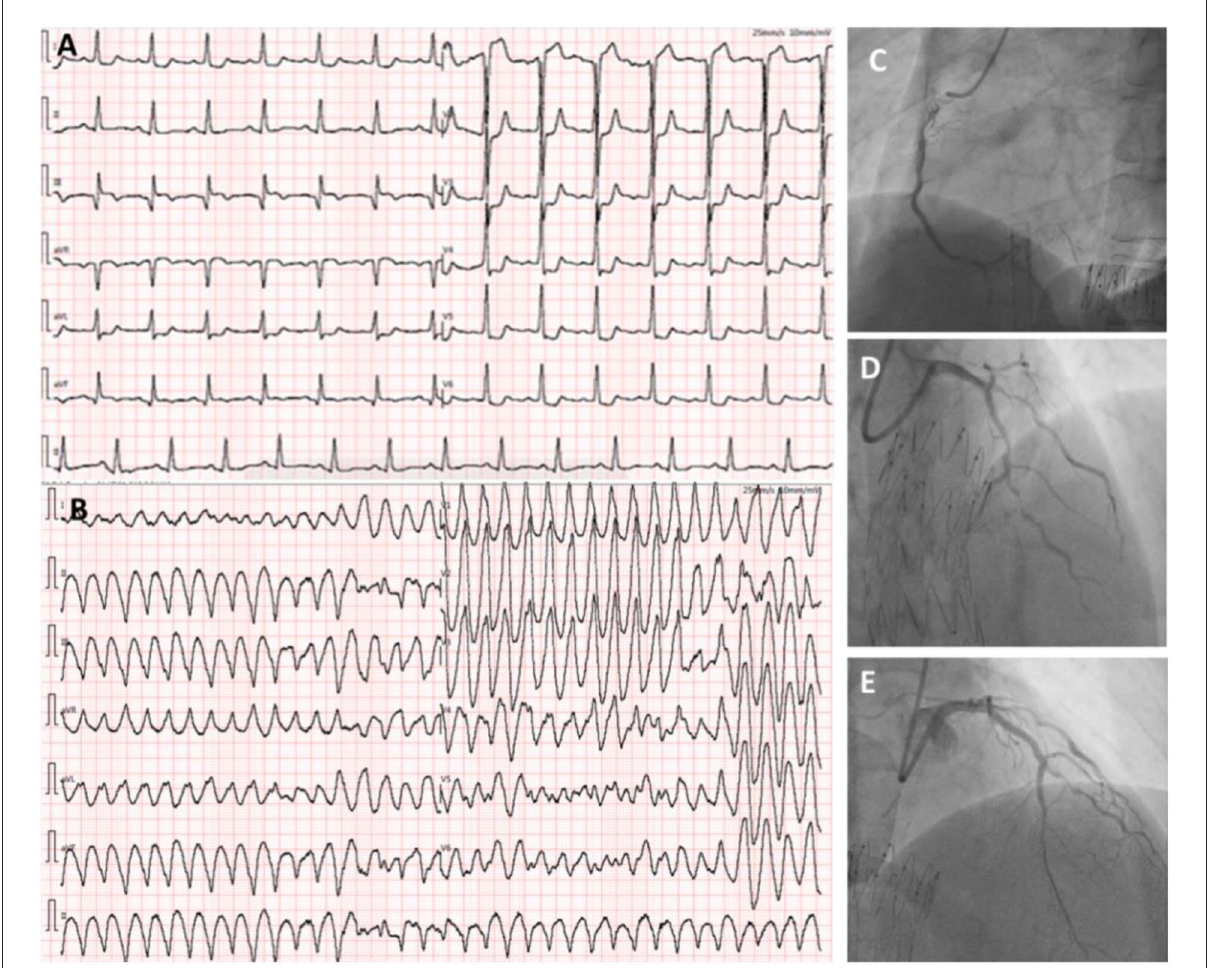
FIGURE3 ECG showing ST-elevation in V1 and ST-depression in I, aVL, and V1–V6 leads when the patient complained of severe chest pain (A) . There is an ES attack during the reported chest pain (B) . Coronary angiography demonstrated patency of RCA (TIMI flow grade II-III) (C) . Three stents